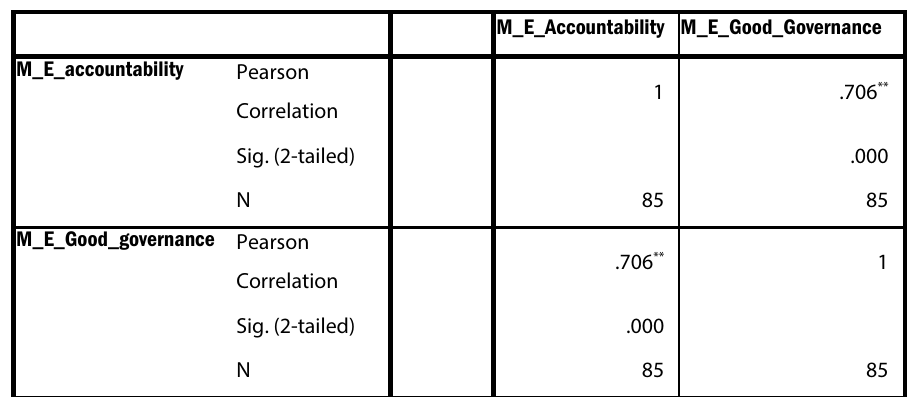
Table 3: Correlation of M&E Accountability and Good Governance